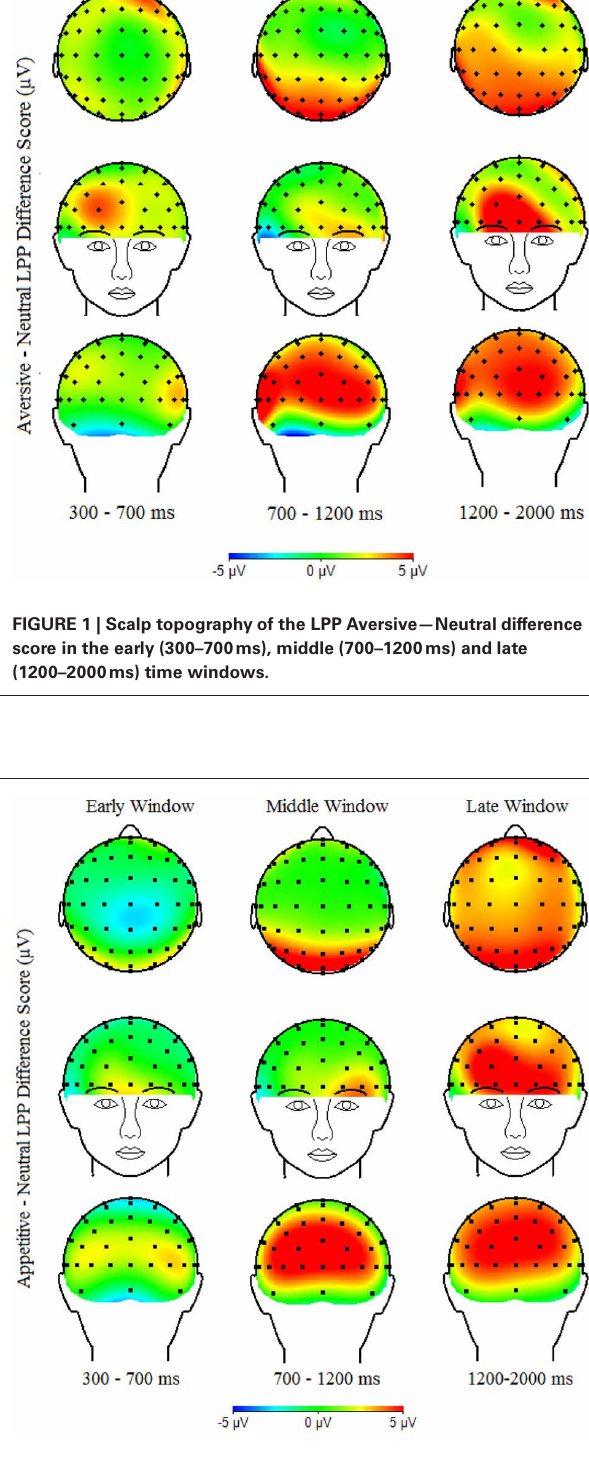
FIGURE 2 | Scalp topography of the LPP Appetitive—Neutral difference score in the early (300—700ms), middle (700–1200ms) and late (1200–2000ms) time